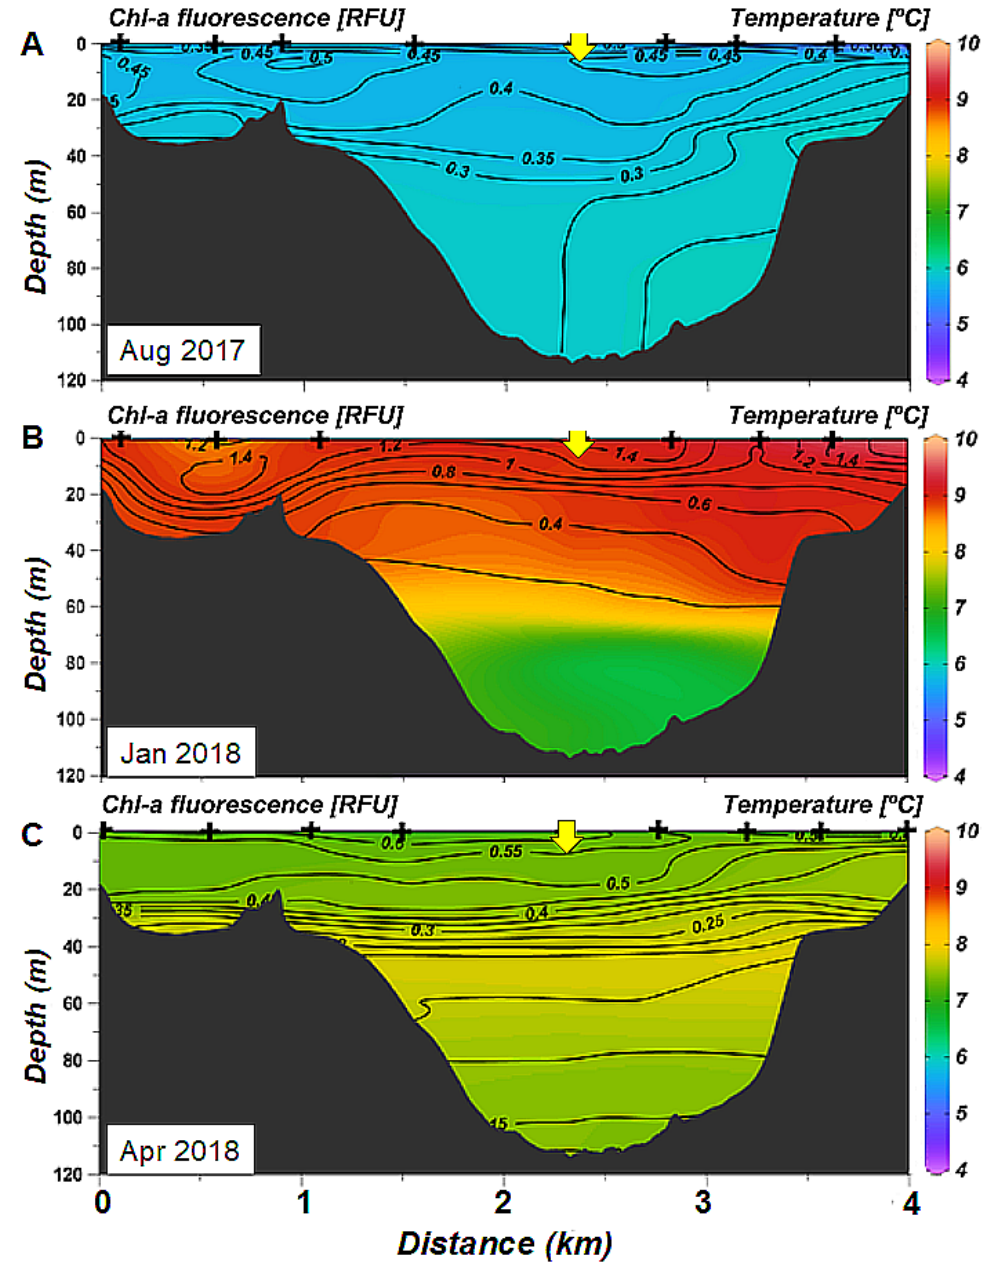
Figure 6. Cross-bay section of temperature (color gradient) and Chl-a fluorescence (isolines) for ( A ) August 2017; ( B ) January 2018; and ( C ) April 2018. The intersection between cross-bay and along-bay sections is marked with a yellow arrow.